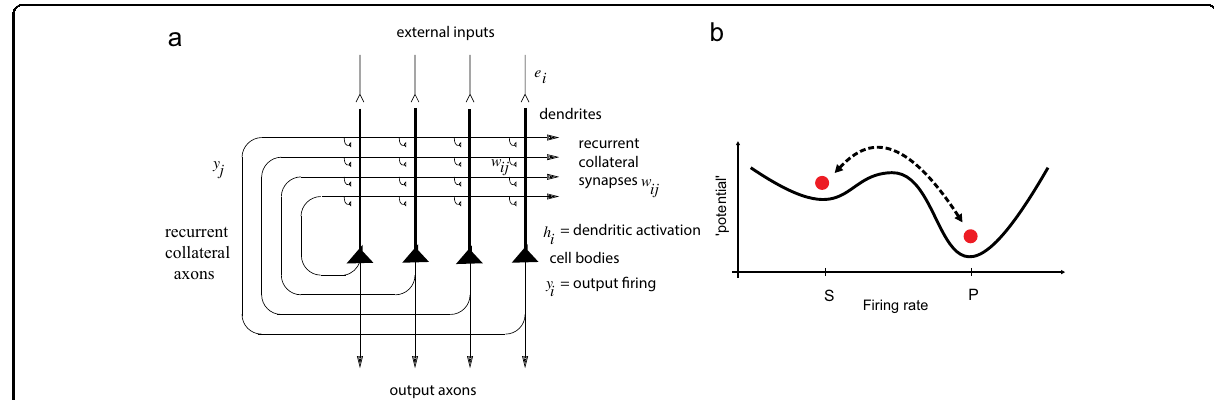
Fig. 1 Attractor Networks. a Architecture of an attractor network. External inputs e i activate the neurons in the network, and produce fi ring y i , where i refers to the i ’ th neuron. The neurons are connected by recurrent collateral synapses w ij , where j refers to the j th synapse on a neuron. By these synapses, an input pattern on e i is associated with itself, and thus the network is referred to as an autoassociation network. Because there is positive feedback via the recurrent collateral connections, the network can sustain persistent fi ring. These synaptic connections are assumed to be formed by an associative (Hebbian) learning mechanism. The inhibitory interneurons are not shown. They receive inputs from the pyramidal cells and make negative feedback connections onto the pyramidal cells to control their activity. The recall state (which could be used to implement short-term memory or memory recall) in an attractor network can be thought of as the local minimum in an energy landscape. b Energy landscape. The fi rst basin (from the left) in the energy landscape is the spontaneous state with a low fi ring rate (S), and the second basin is the high fi ring rate attractor state, which is ‘ persistent ’ (P) in that the neurons that implement it continue fi ring at a high rate. The vertical axis of the landscape is the energy potential. The horizontal axis is the fi ring rate, with high to the right. In the normal condition, the valleys for both the spontaneous and for the high fi ring attractor state are equally deep, making both states stable. In general, there will be many different high fi ring rate attractor basins, each corresponding to a different memory. In schizophrenia, it is hypothesized that the high fi ring rate (P) state is too shallow due to low fi ring rates, providing instability which leads to the cognitive symptoms of poor short-term memory and attention in the prefrontal cortex. It is also hypothesized that in schizophrenia the spontaneous fi ring rate state (S) is too shallow due to reduced inhibition and that this leads to noise-induced jumping into high- fi ring rate states in the temporal lobe that relate to the positive symptoms of schizophrenia such as hallucinations and delusions. In contrast, it is hypothesized that in obsessive – compulsive disorder, the basin for the high fi ring attractor state is deep, making the high fi ring rate attractor state that implements for example short-term memory too stable, and very resistant to distraction 29 . This increased depth of the basin of attraction of the persistent state may be associated with higher fi ring rates of the neurons if for example the state is produced by increased currents in NMDA receptors 29